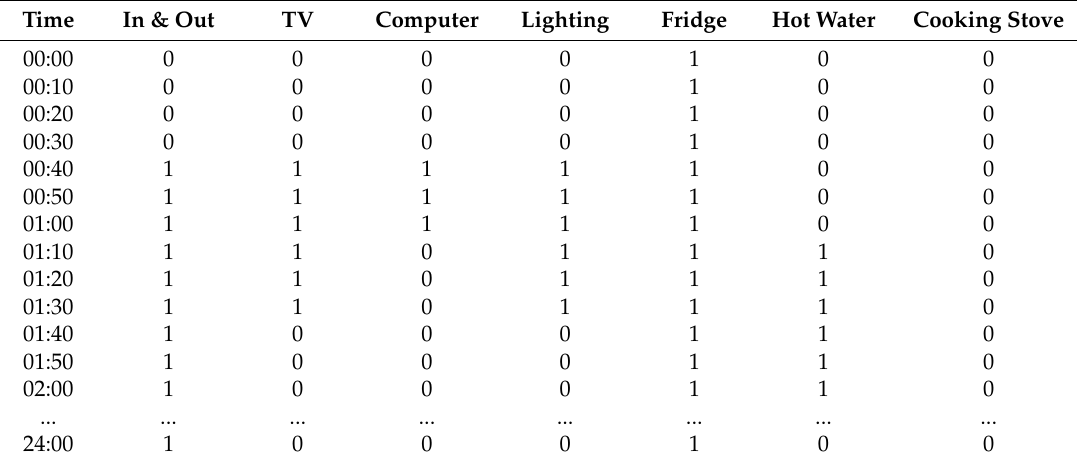
Table 5. Sample of daily energy schedule of household on 28th Aug